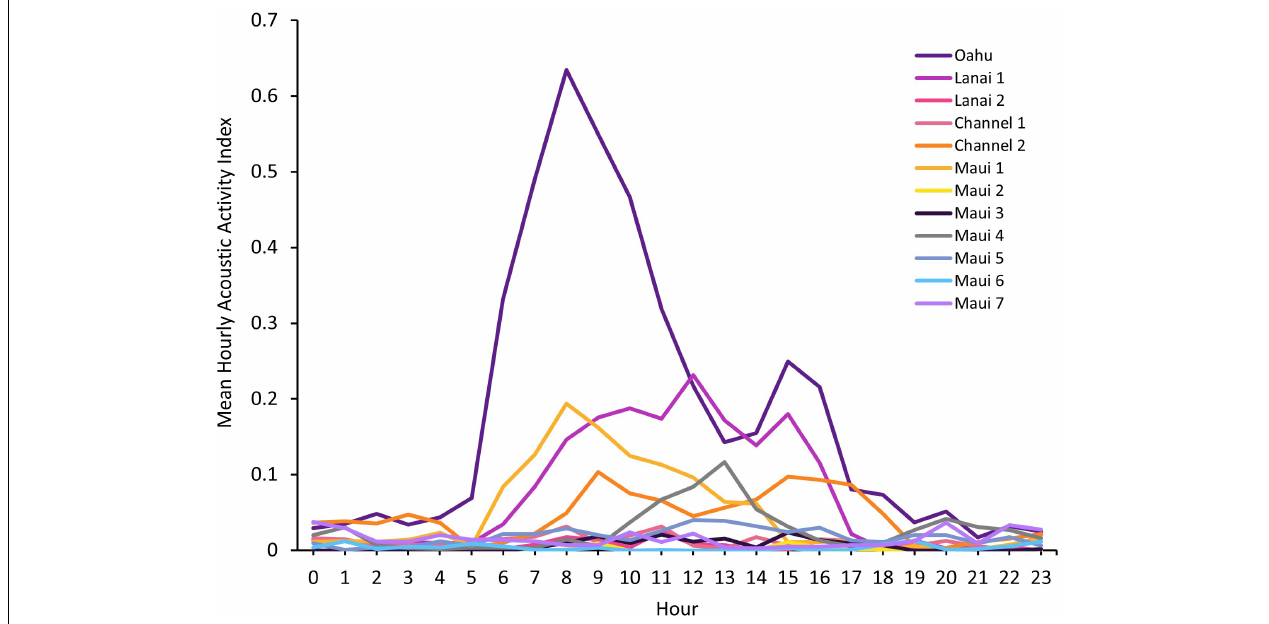
FIGURE 3 | Mean hourly Acoustic Activity Index (AAI), ranging from 0 to 3.5, by hour of day for each Ecological Acoustic Recorder (EAR) deployment. Along the x-axis hour 0 begins at midnight, and hour 23 begins at 2300 h.